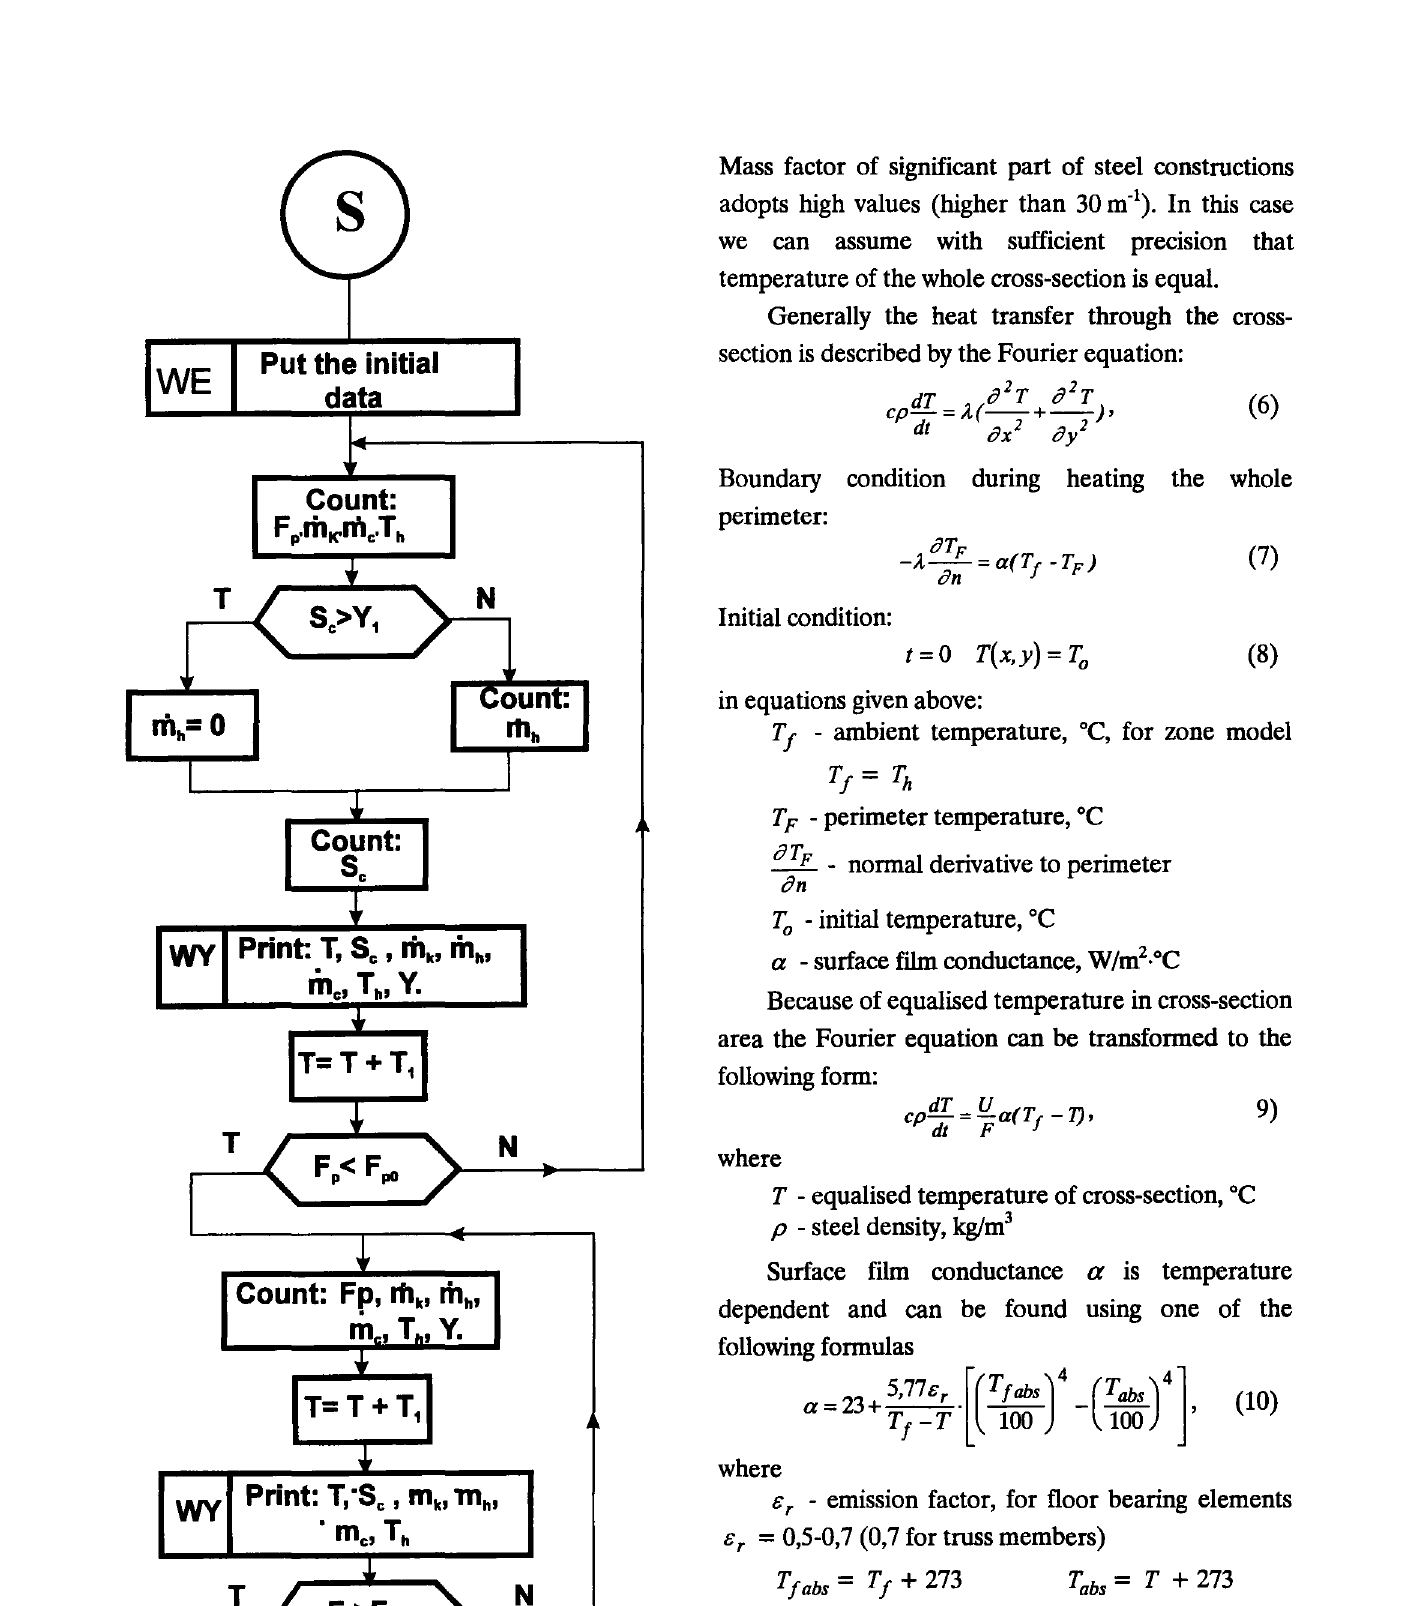
Fig. 2. Block diagram of computer program for calculating temperatures in the room during